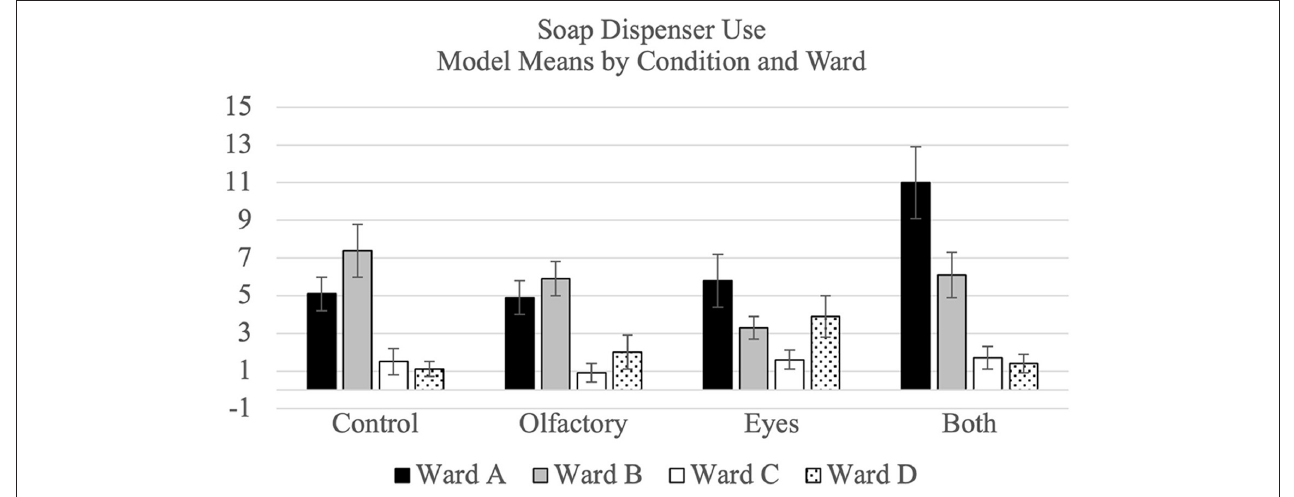
FIGURE 1 | Consort flow